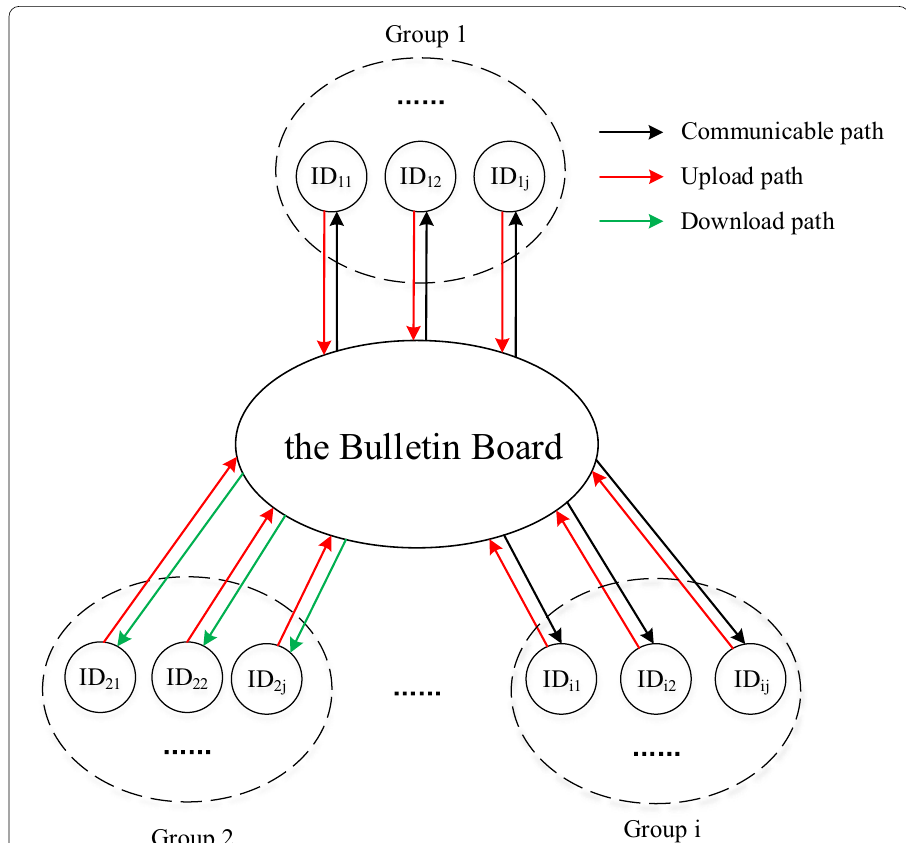
Fig. 1 Lightweight anonymous communication model. This represents the process of uploading and downloading ciphertexts